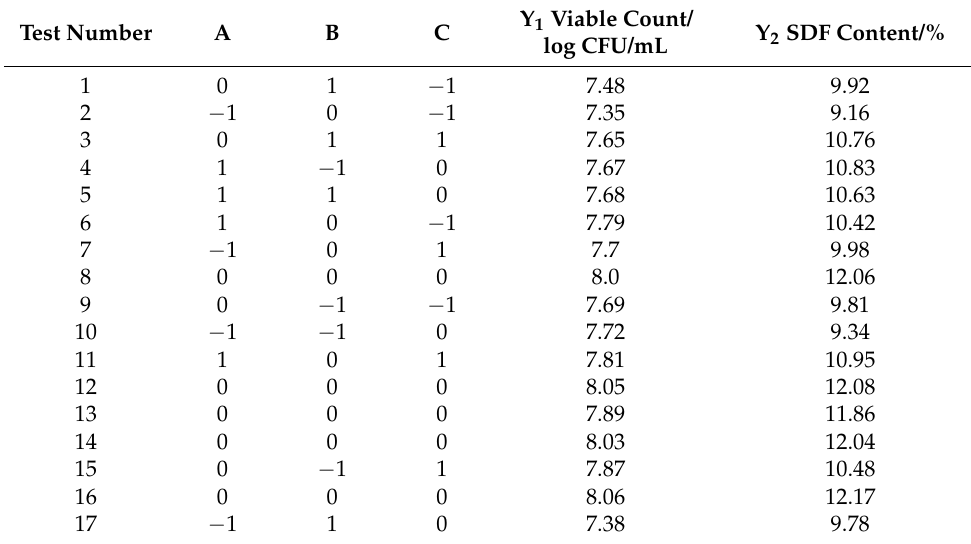
Table 2. Design and results of the response surface